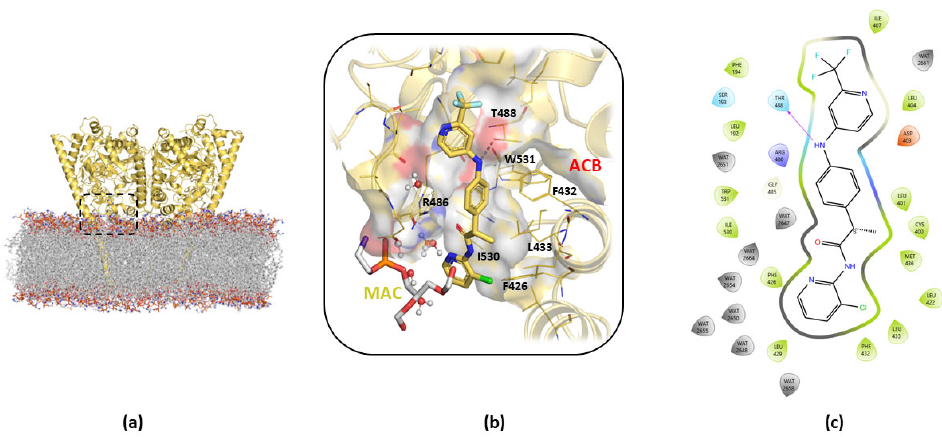
Figure 3. Details of the cluster b0 of the B3db1 binding mode of TPA14 in pocket 1 of r FAAH monomer B after 100 ns of MDs. ( a ) Global overview of the TPA14 binding site, indicated by the black dashed rectangle. ( b ) Zoom details of TPA14 (yellow stick) cluster b0 binding mode and its interactions with the surrounding key residues. ( c ) TPA14 2D diagram interaction obtained with Maestro GUI. Magenta arrow indicates the H ‐ bond interaction with T488.